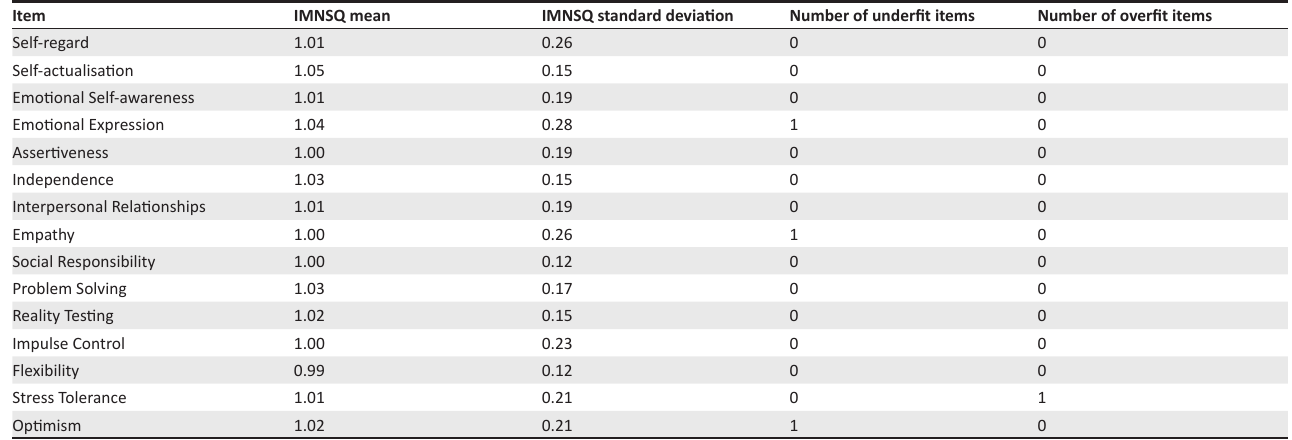
TABLE 1: Number of items that misfit the Rasch model. Item IMNSQ mean IMNSQ standard deviation Number of underfit items